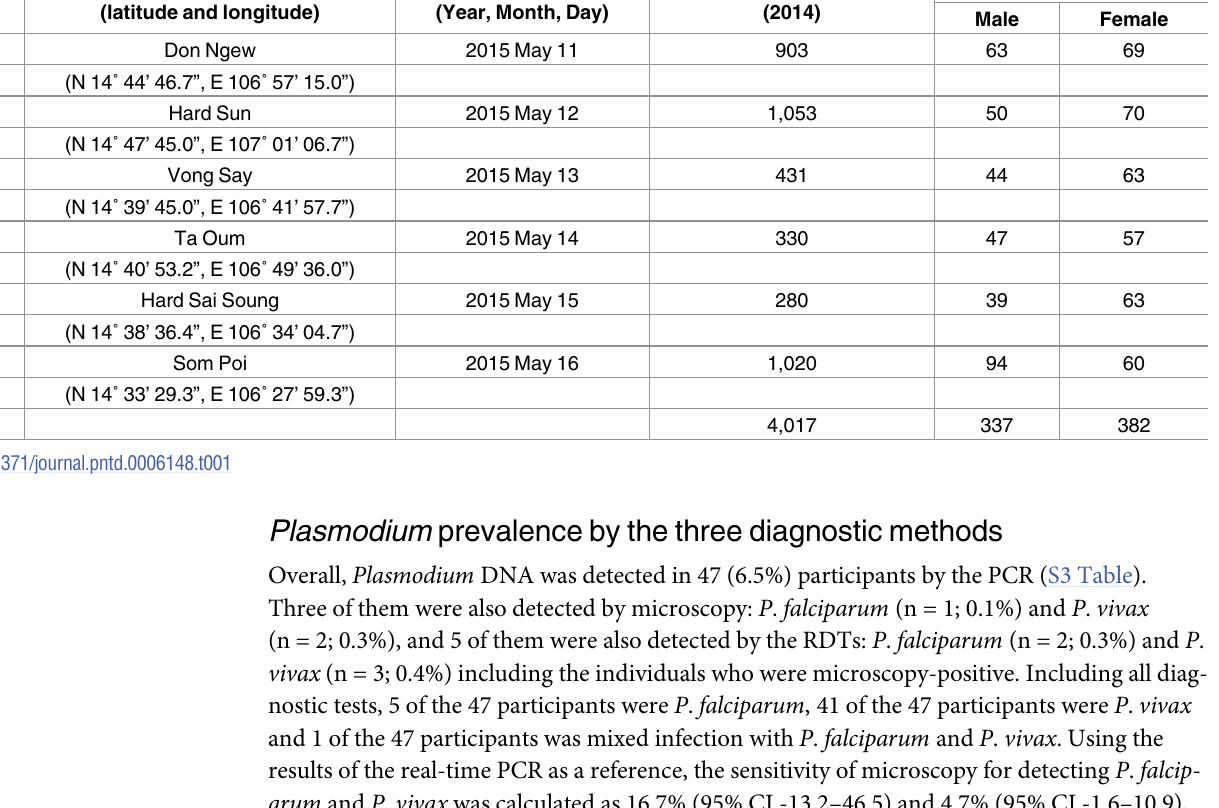
Table 1. The numbers of participants in the three districts of Attapeu province. District Village Name (latitude and